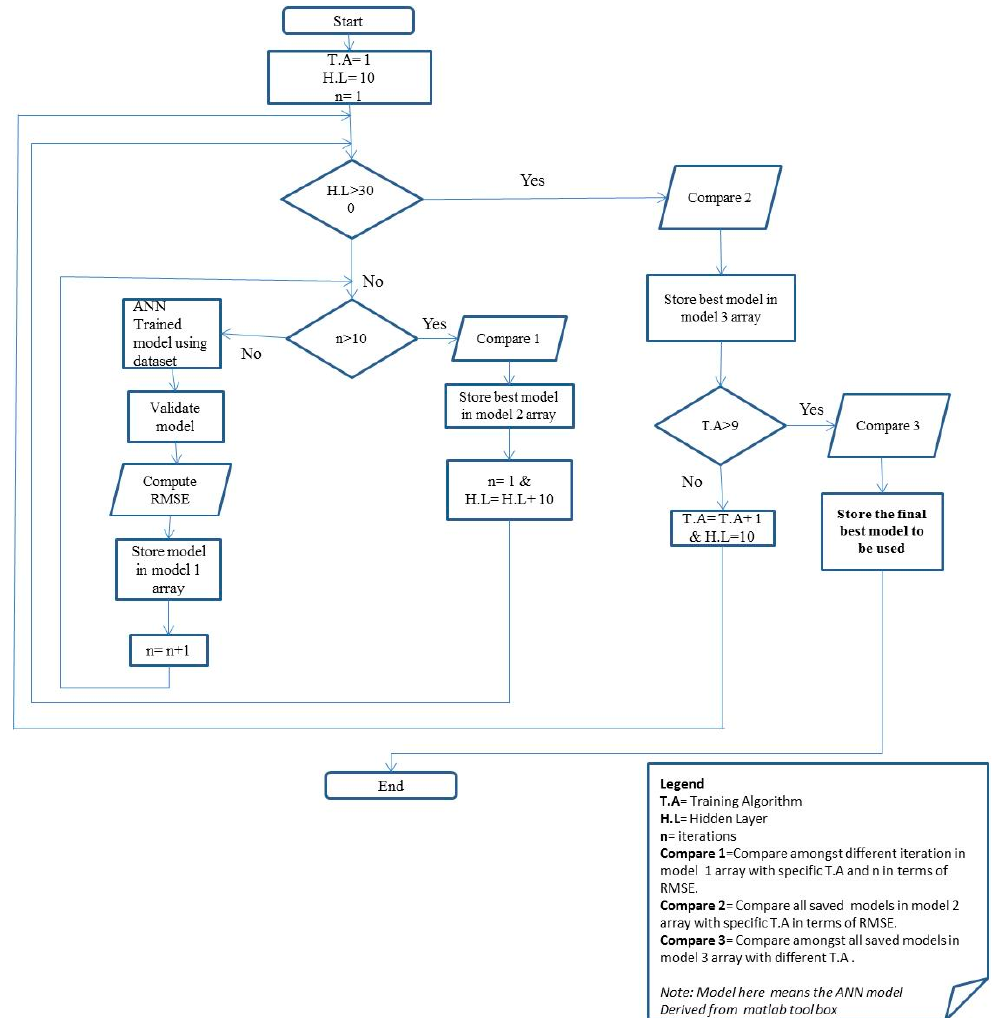
Figure 4. Method to find the best ANN to predict PV power.